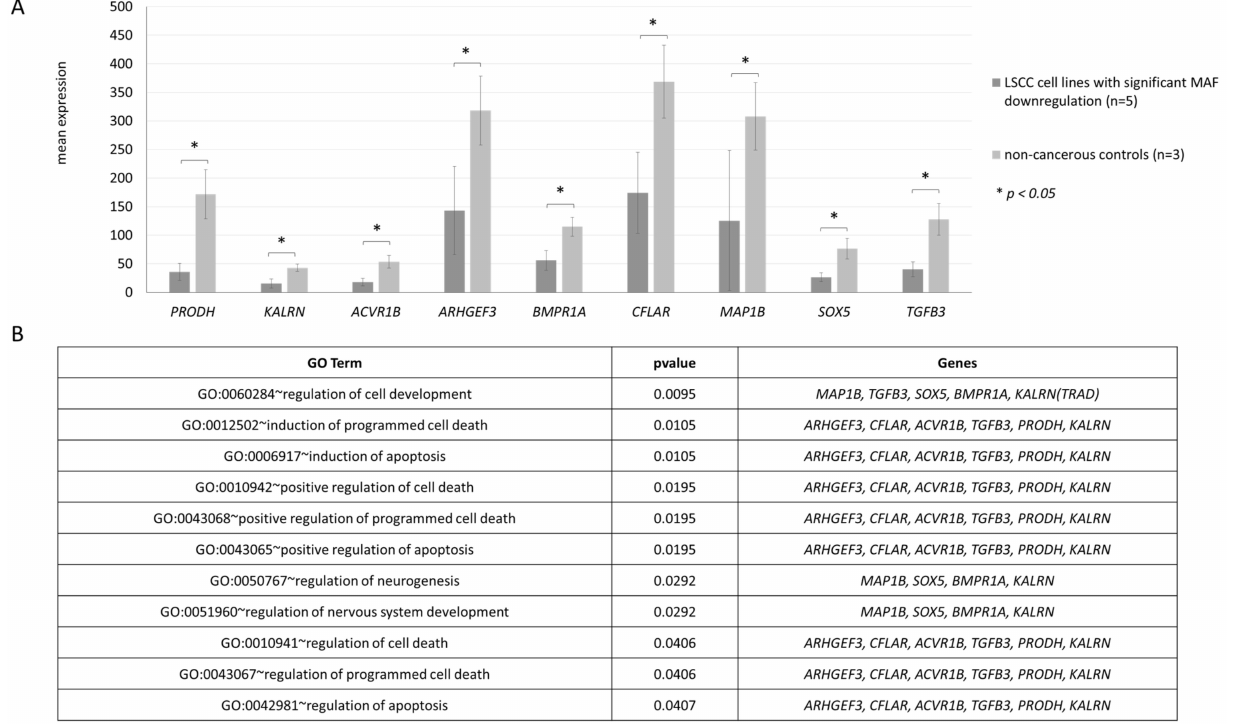
Figure 3. Results of combined FIMO and DAVID GO analysis. ( A ) Downregulated genes in LSCC (expression microarray data), with MAF binding motif in the promoter sequence and a putative role in apoptosis regulation. Human larynx total RNA (Stratagene, Agilent Technologies, Waldbronn, Germany) and total RNA from the bronchial airway epithelia reconstituted in vitro (Epithelix Sarl, Geneve, Switzerland) as well as normal mucosa from surgical margin were used as non-cancerous controls. ( B ) Processes regulated by selected genes, related to apoptosis and cell development, potentially downregulated as a consequence of MAF loss in